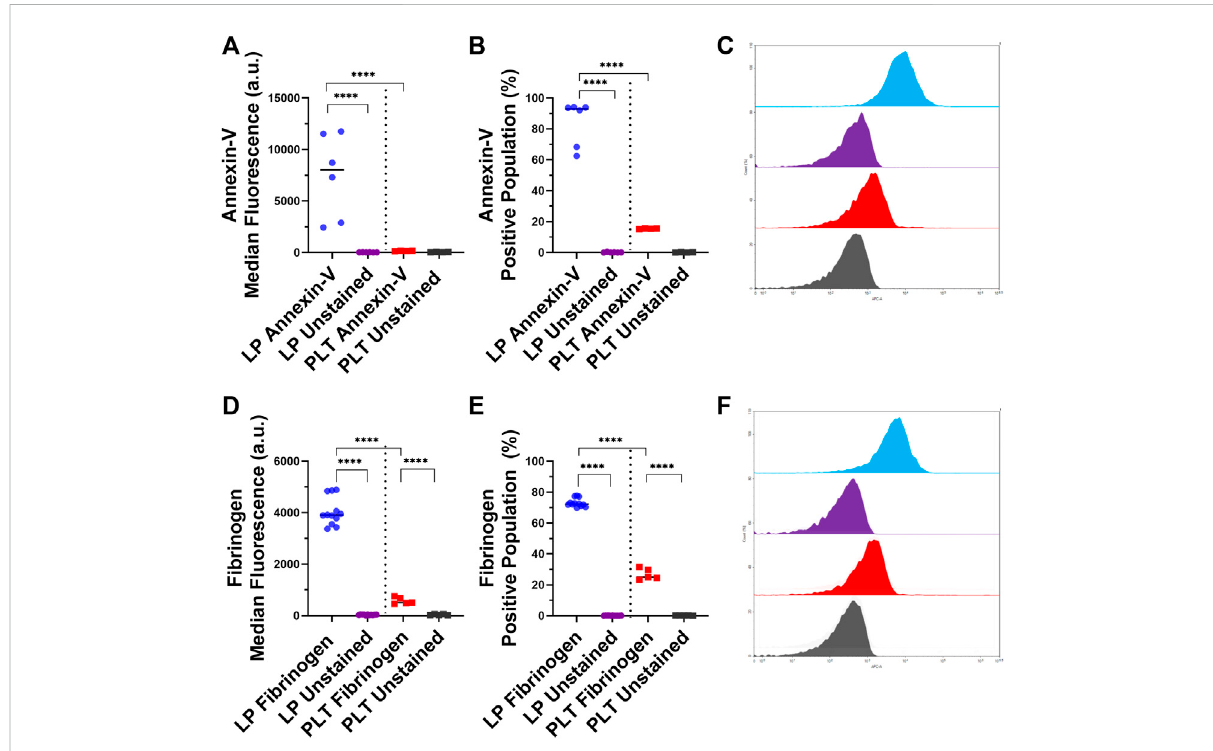
FIGURE 2 Characterization of Phosphatidylserine Exposure and Fibrinogen Binding on Lyophilized and Fresh Human Platelets. Quanti fi cation of expression level (left),percentpositiveevents(middle),and representativehistograms (right), for (A,B,C) phosphatidylserine [LP: n = 6,PLT: donors = 2, n = 4], and (D,E,F) fi brinogen binding [LP: n = 12, PLT: donors = 2, n =